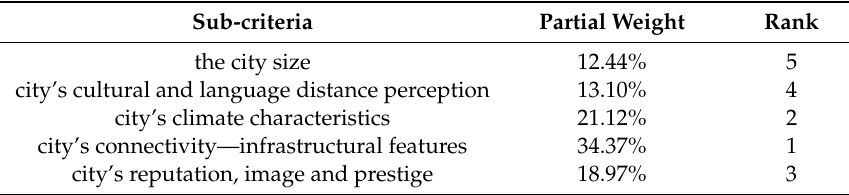
Table 8. Sub-criteria relative weight and rank of city structural factors.